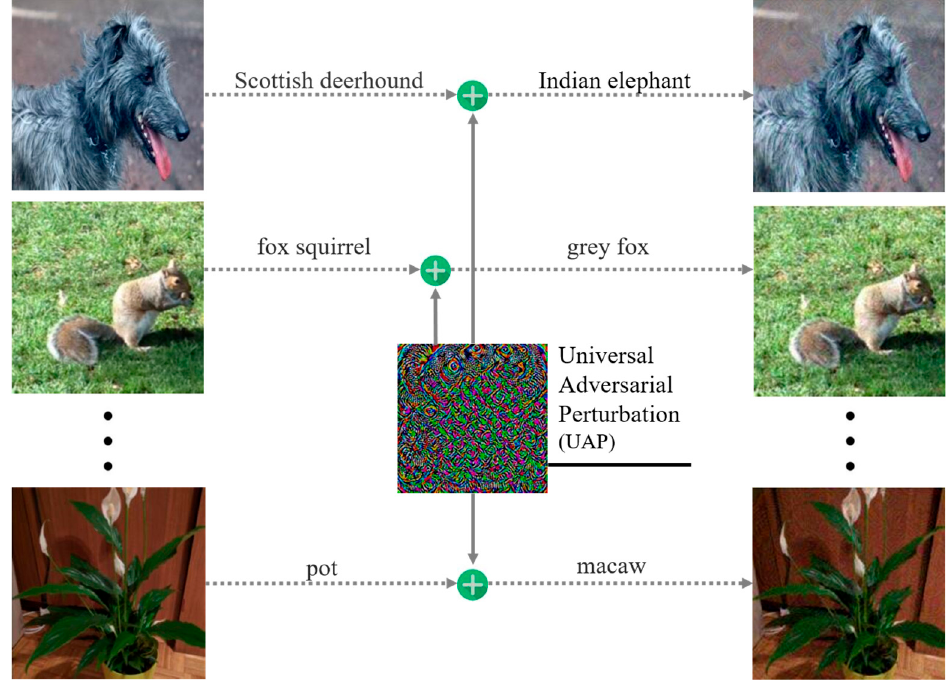
Figure 1. Universal adversarial perturbation.